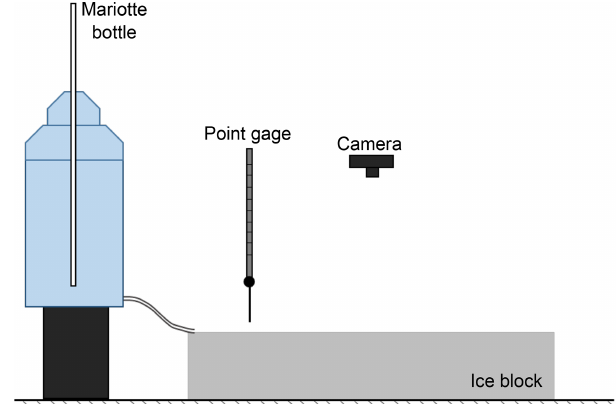
Figure 2. Experimental setup for centimeter-scale laboratory melt- water meandering